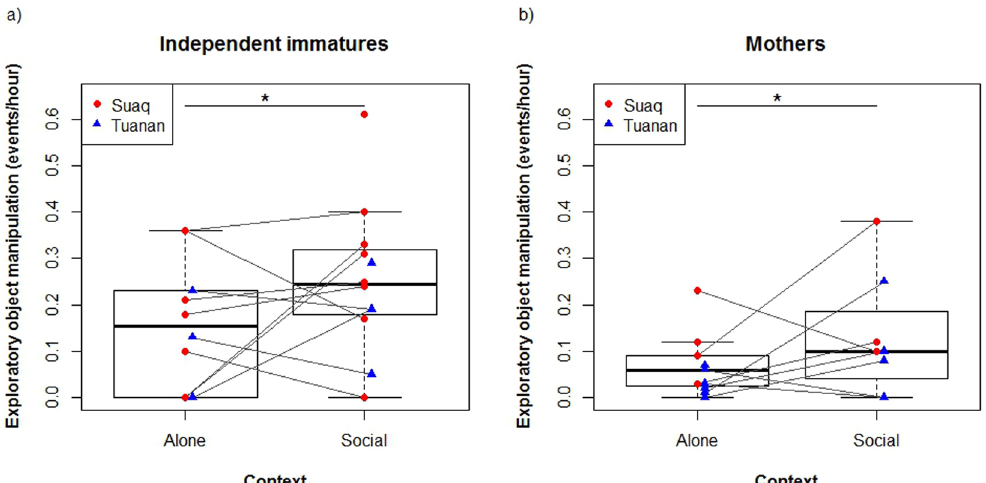
Figure 6. Rates of exploratory object manipulation (events per hour) in the solitary context (when being alone or with dependent or semi-dependent offspring only, “Alone”) and in the social context (when being with at least one association partner that is not the own dependent or semi dependent offspring, “Social”) for independent immatures at Suaq and Tuanan ( a ), as well as for adults at Suaq and Tuanan ( b